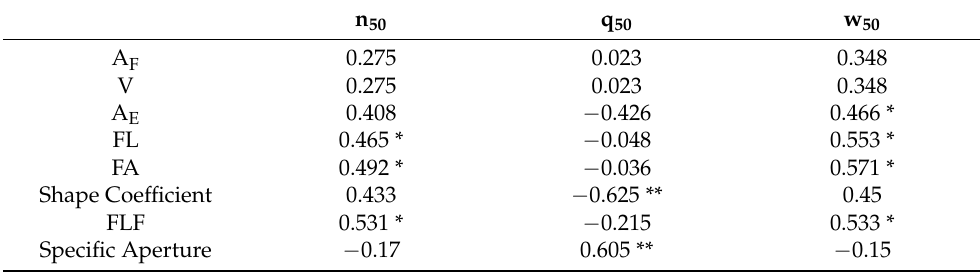
Table 7. Spearman’s rank-order correlation between building and air tightness parameters, condi- tional on observed fenestration quality.